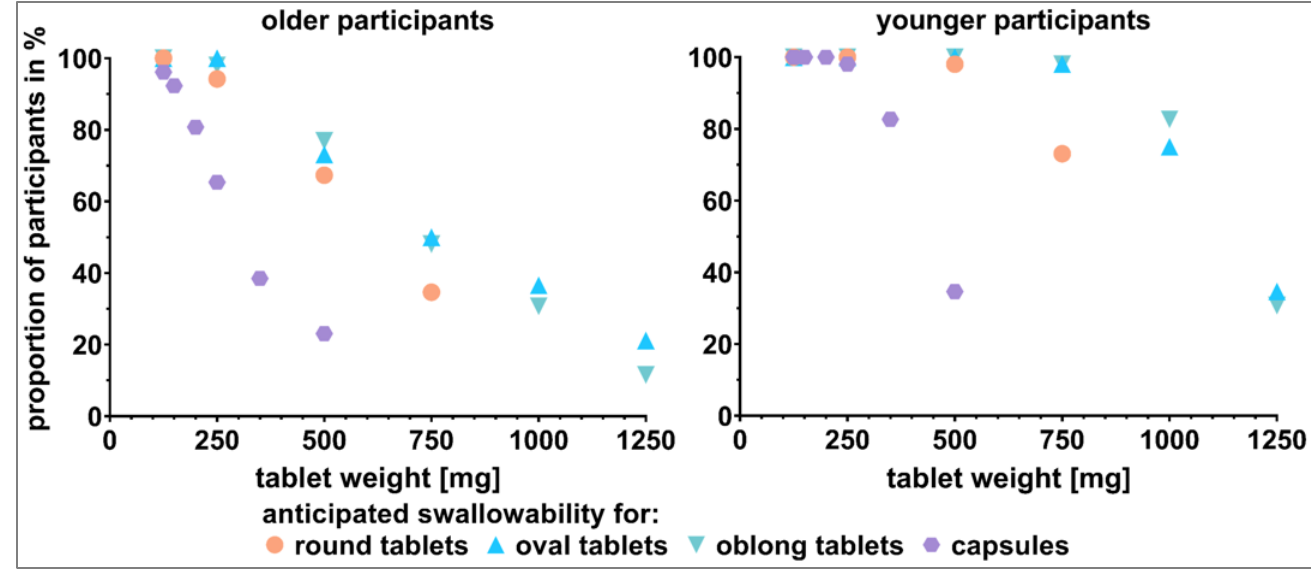
Figure 5. Visual perception of dosage forms’ swallowability by older participants ( left panel) and younger participants ( right panel). Capsules (size 4 to 00 with anticipated weight of 125 mg to 500 mg), round shaped tablets (125 mg to 750 mg), as well as oval and oblong shaped tablets (125 mg to 1250 mg) were shown to the participants in the shape-showcases.